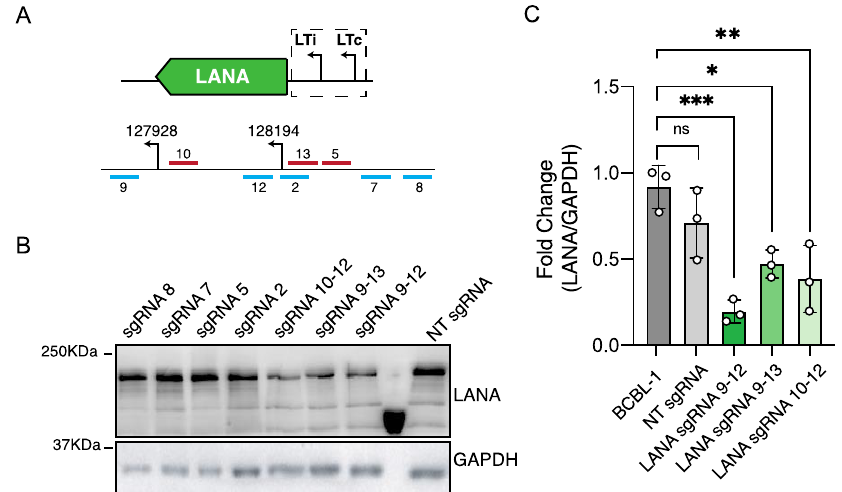
Figure 6. CRISPRi silencing of latent genes in BCBL-1 cells. ( A ) Region of the viral genome encoding LANA (ORF73) and position of the sgRNAs. ( B ) Immunoblot analysis of LANA in iSLK-219 cells, and iSLK-219-dC9K cells transduced with a non-targeting (NT) sgRNA or a LANA specific sgRNA. Image representative of three biological replicates. ( C ) Quantification of the immunoblot data for sgRNAs that silenced LANA. Error bars: standard deviation (one-way ANOVA, *** p = 0.0004, ** p = 0.004, * p = 0.0124, ns, not significant).